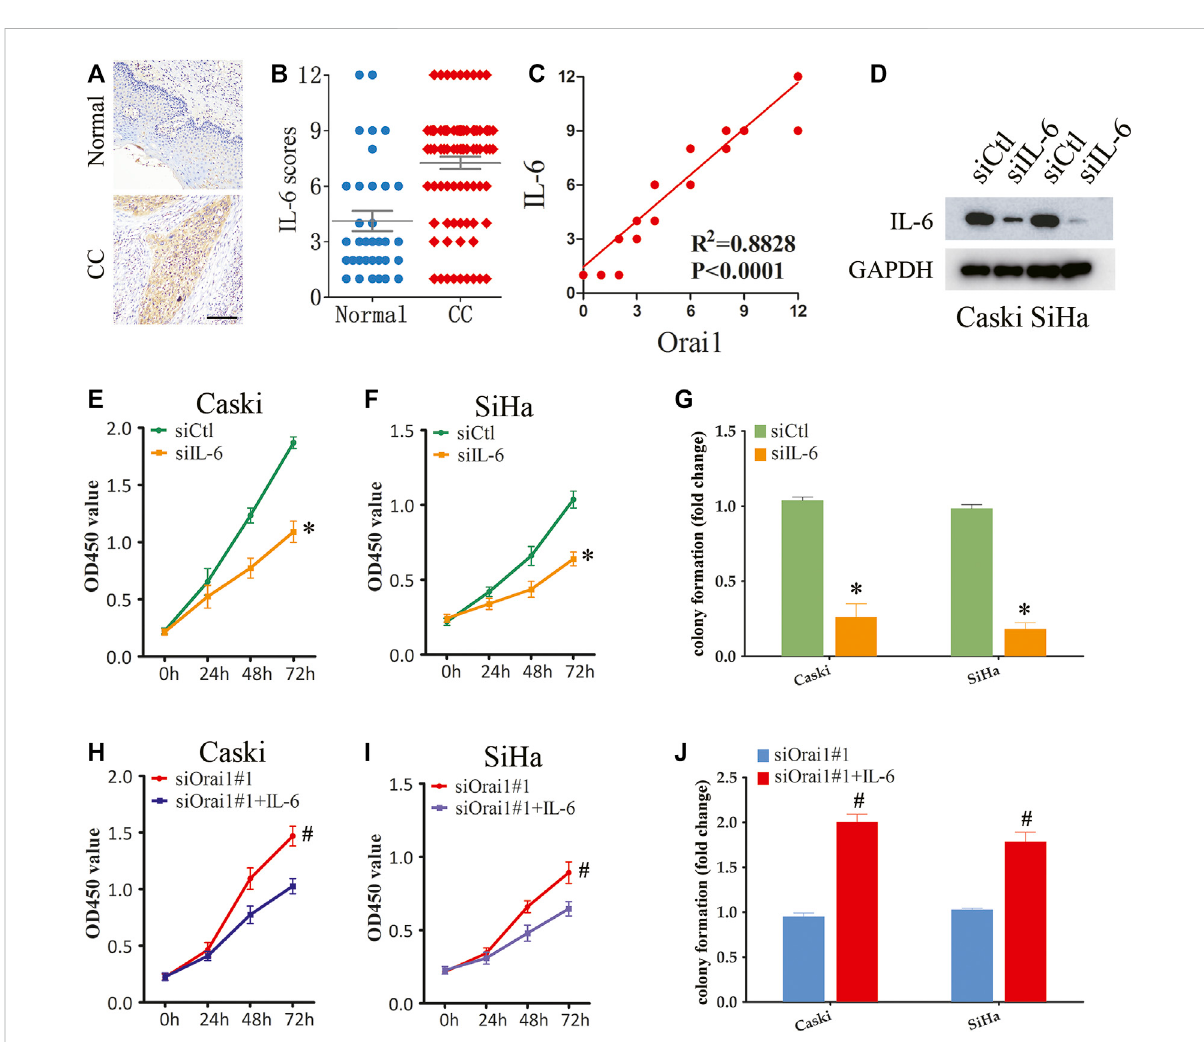
FIGURE 6 Orai1-mediated SOCE promotes cervical cancer cell growth through IL-6 signaling (A – B) Representative images and IHC analysis of IL-6 protein expression in normal ( n = 34) and cervical cancer (CC) tissues ( n = 87). Scare bar = 100 μ m. (C) Pearson correction of Orai1 expression with IL-6 expression. (D) Immunoblot showing Orai1 protein levels in Caski and SiHa cells transfected IL-6 siRNA. (E) Viability of Caski cells transfected with siCtl or siIL-6. (F) Viability of SiHa cells transfected with siCtl or siIL-6. (G) Number of colonies formed by Caski and SiHa cells transfected withsiCtlorsiIL-6. (H – I) ViabilityofCaski (H) andSiHa (I) cellstransfectedwith siOrai1andtreatedwithIL-6. (J) NumberofcoloniesformedbyCaski and SiHa cells transfected with siOrai1 and treated with IL-6. Values are means ± SEM, * p < 0.05 compared to siCtl or control group. #, p < 0.05 compared to